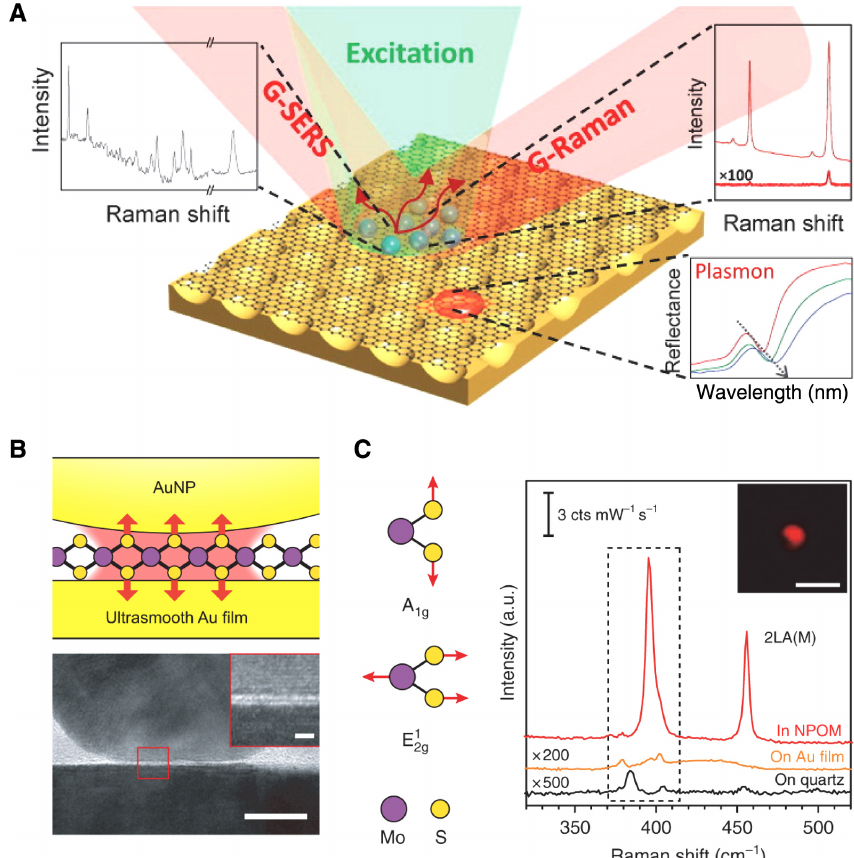
Figure 2: Raman scattering of 2D materials enhanced by plasmonic nanostructures. (A) A hybrid graphene–plasmonic structure for studying light–matter interaction with Au-void nanostructures exhibiting resonances in the visible range. Enhanced coupling of graphene to the plasmon modes of the nanovoid arrays results in significant frequency shifts of the underlying plasmon resonances, enabling 30% enhanced absolute light absorption by adding a monolayer graphene and up to 700-fold enhancement of the Raman response of the graphene. (B) The quantitative probing of the vertical and horizontal SERS of MoS plasmonic antennas with a gap distance reaching down to a well-defined subnanometer scale. Layered 2D MoS arrangement were designed as probes to create robust and uniform gaps with intervals of 0.62 nm, indicated by schematic and high- resolution transmission electron microscope images. (C) Atomic displacements of the phonon modes in the unit cell of 1 L MoS scattering spectra and image (inset) show the plasmon-enhanced Raman signals, scale bar, 2 μ m. Reproduced/adapted with permission from Zhu et al. [88] (A) and Chen et al. [92] (B,